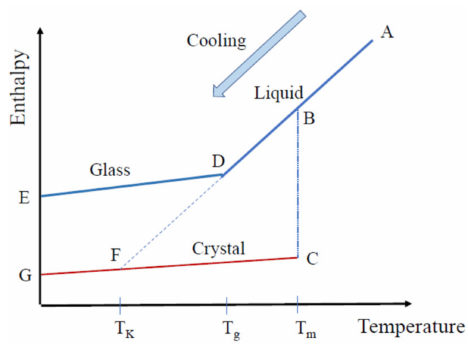
Figure 13. Temperature dependence of the enthalpy for the liquid (AB), supercooled liquid (BD), glass (DE), and crystalline (CG) states, where T m , T g , and T K are the melting, glass transition, and Kauzmann temperatures,